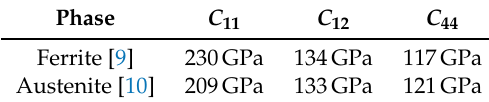
Table 2. Single-crystal elastic